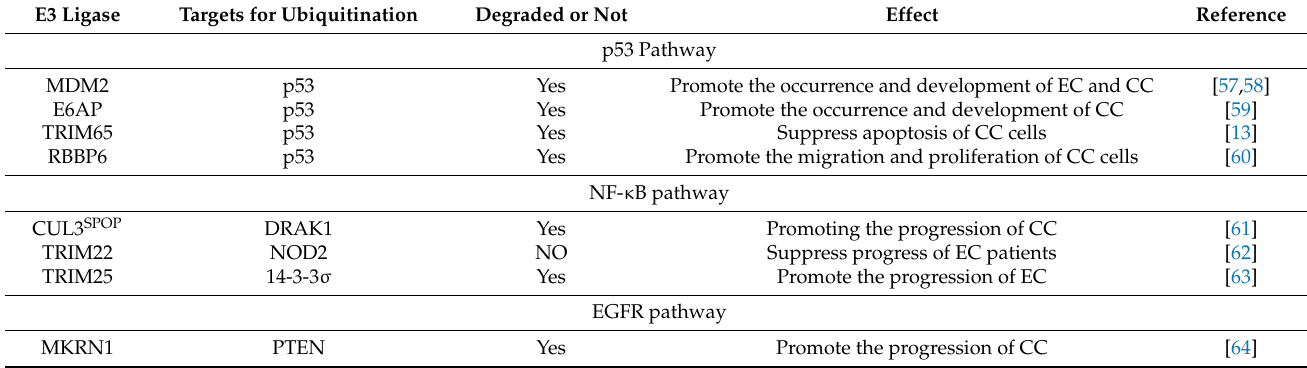
Table 1. Functional roles of E3 ligases in EC and